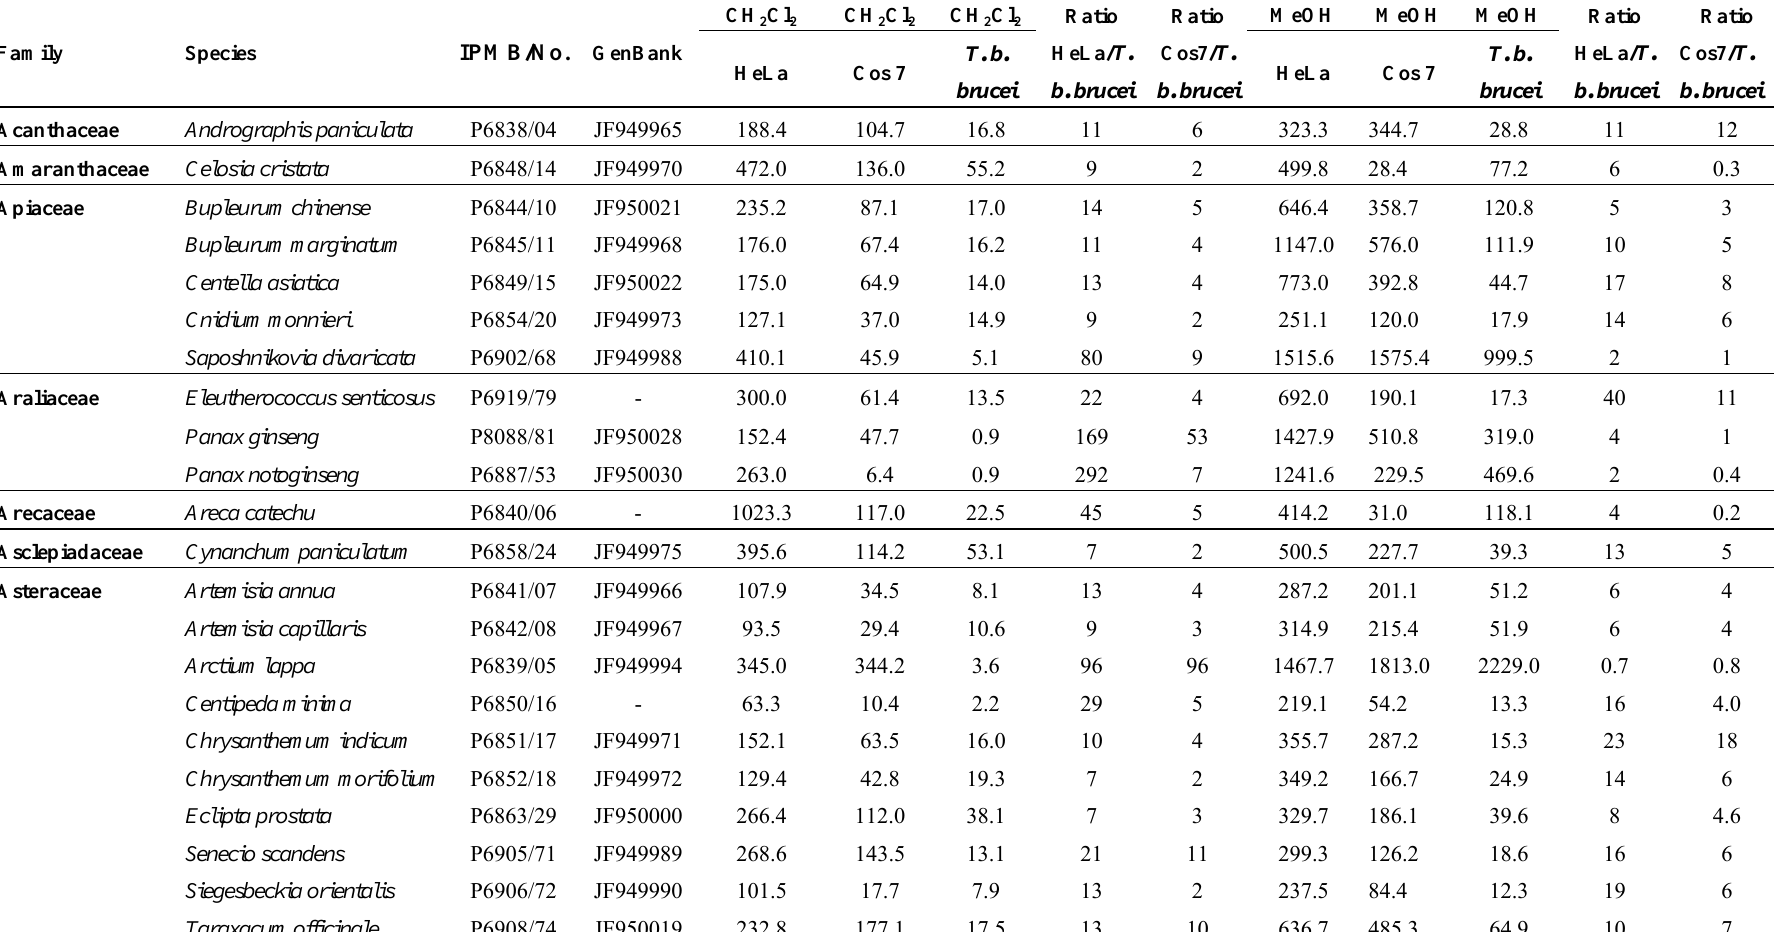
Table 4. Cytotoxicity against HeLa cancer cells, Cos7 fibroblasts and Trypanosoma brucei brucei of organic extracts obtained from 82 medicinal